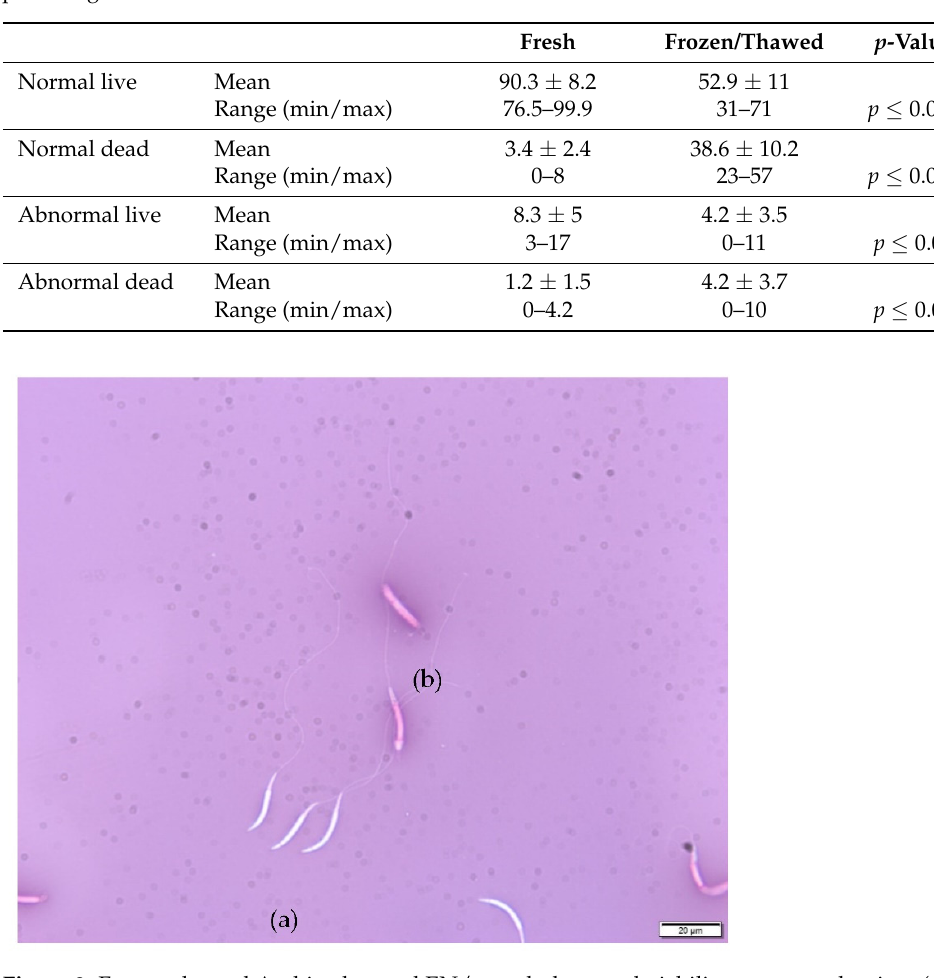
Figure 3. Frozen-thawed Arabian bustard EN/morphology and viability sperm evaluation: ( a ) the membrane of uncoloured sperm is considered as intact, and ( b ) damaged sperm membrane is positive for eosin coloration, therefore coloured in pink (Olympus BX61, 400× brightfield).